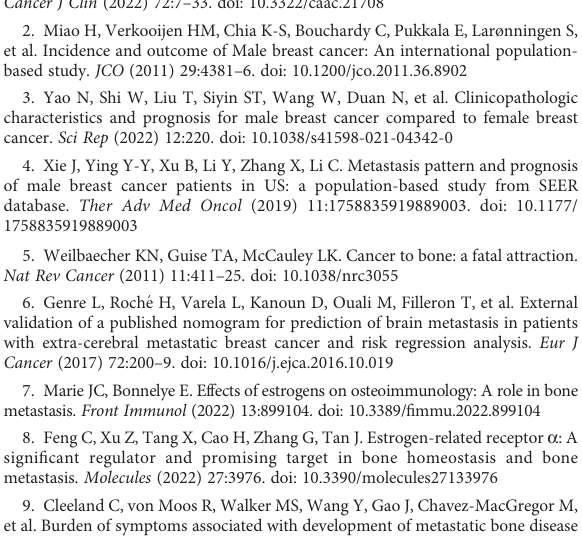
SUPPLEMENTARY FIGURE S2 A visualized dynamic prognostic nomogram for predicting the OS in MBCBM patients. The curve of the predicted probability of survival for this patient over time (A) . 95% con fi dence intervals of the 12-, 24-, 36-, 48-, and 60months OS survival probabilities for this patient (B) . Numerical summary for prognostic analysis of this patient at different OS (C) . SUPPLEMENTARY FIGURE S3 A visualized dynamic prognostic nomogram for predicting the CSS in MBCBM patients. The curve of the predicted probability of survival for this patient over time (A) . 95% con fi dence intervals of the 12-, 24-, 36-, 48-, and 60months CSS survival probabilities for this patient (B) . Numerical summary for prognostic analysis of this patient at different CSS (C)